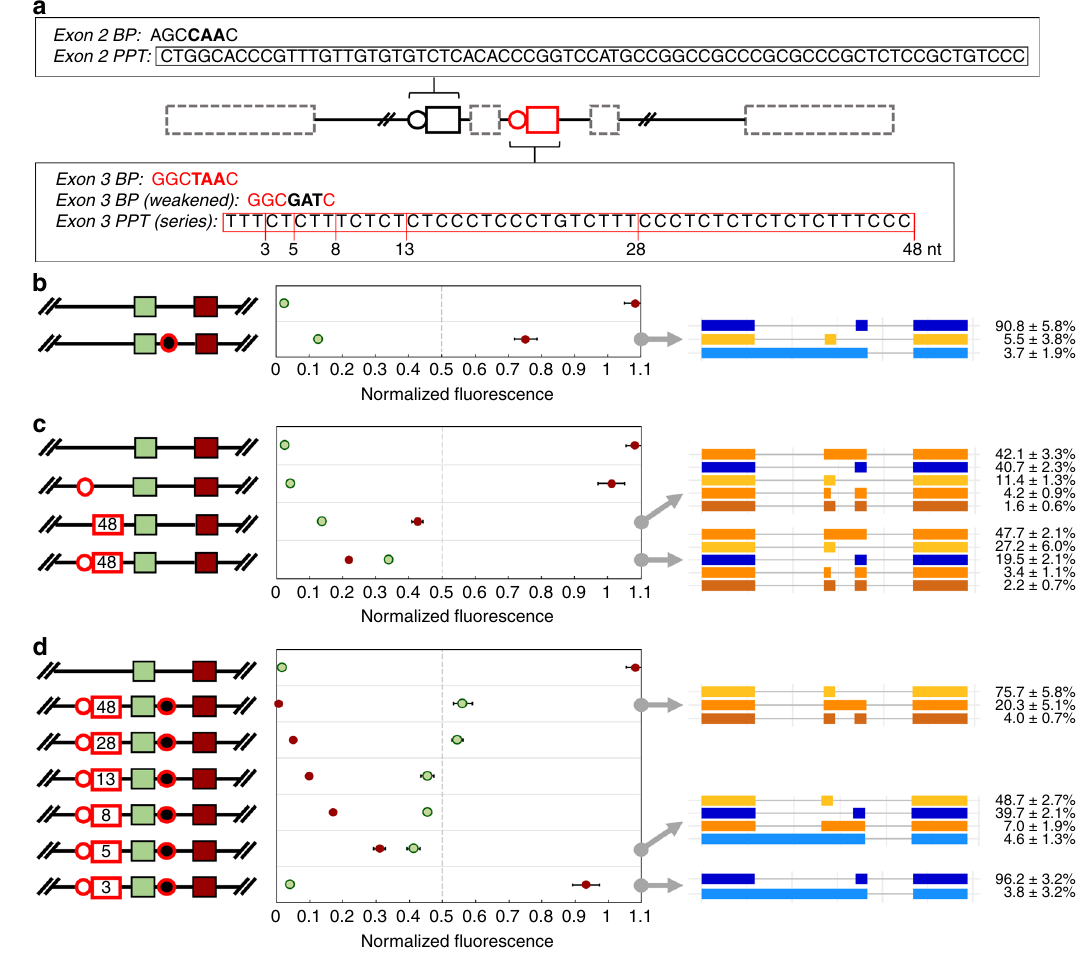
Fig. 3 Producing alternate isoform pro fi les by tuning consensus sequence element strengths in the intron framework. a Schematic illustrating the BP and PPT elements associated with exon 2 (black) and exon 3 (red). Native and mutated BP and PPT elements are written (bold text denotes the branchpoint adenosine and associated nucleotides; red lines indicate the PPT sequence lengths, in nucleotides, of elements in the exon 3 PPT series). These BP and PPT elements were characterized in ASD mCherry. mCherry and Clover fl uorescence levels from ASD mCherry devices containing b a mutated exon 3 BP element (black circle with red outline), c a mutated exon 2 BP element (white circle with red outline) and a mutated exon 2 PPT element (white rectangle with red outline indicating PPT sequence lengths in nucleotides), and d serial truncations of modi fi ed exon 2 PPT elements with mutations of the BP elements of both exons 2 and 3. Fluorescence from the splicing devices and controls was quanti fi ed via fl ow cytometry. The median fl uorescence of each population was measured and normalized to the median fl uorescence intensities of the BFP transfection marker and the spliced controls. Median values from biological triplicates were averaged and reported with an error range of ±1 standard deviation. Devices generating distinctive protein isoform pro fi les were further assessed using long-read sequencing and the relative abundance of each isoform was quanti fi ed. Blue represents RNA isoform 1-3-4 and its derivatives; yellow represents RNA isoform 1-2-4 and its derivatives; and orange represents RNA isoform 1-2-3-4 and its derivatives. The RNA isoform abundance percentages include ±1 standard deviation from biological duplicates. Source data are provided as a Source Data fi